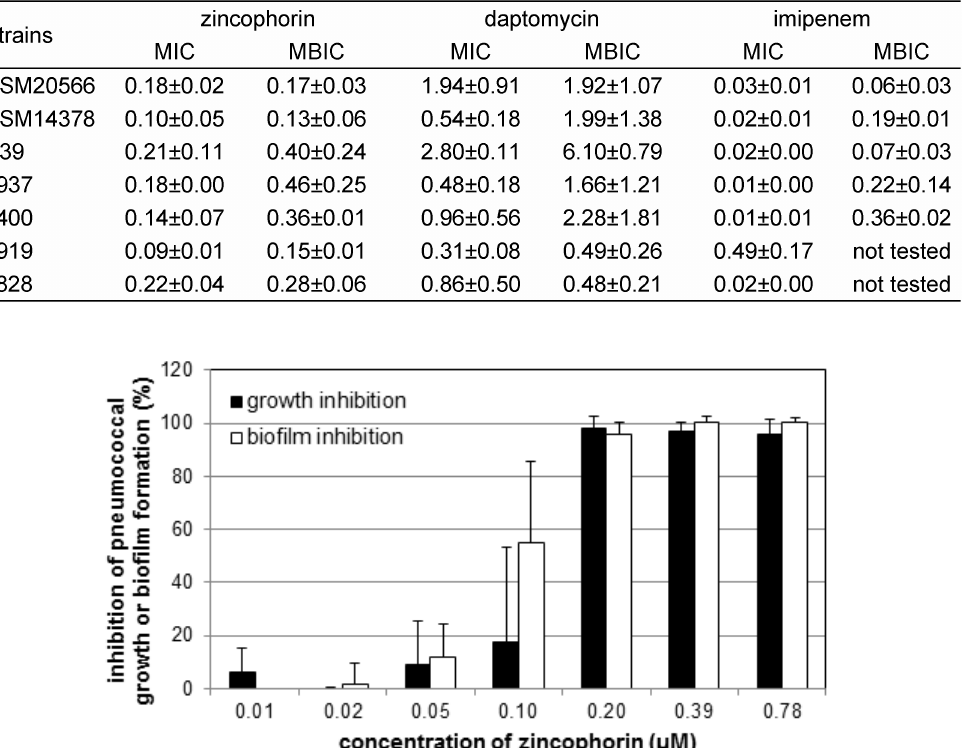
Table 2: Antibacterial activity of zincophorin, daptomycin, and imipenem. Mean MIC and MBIC values in μM with standard deviation determined for three reference strains and four clinical isolates of S.pneumoniaein microtiter broth dilution and biofilm assay, respectively, are shown.